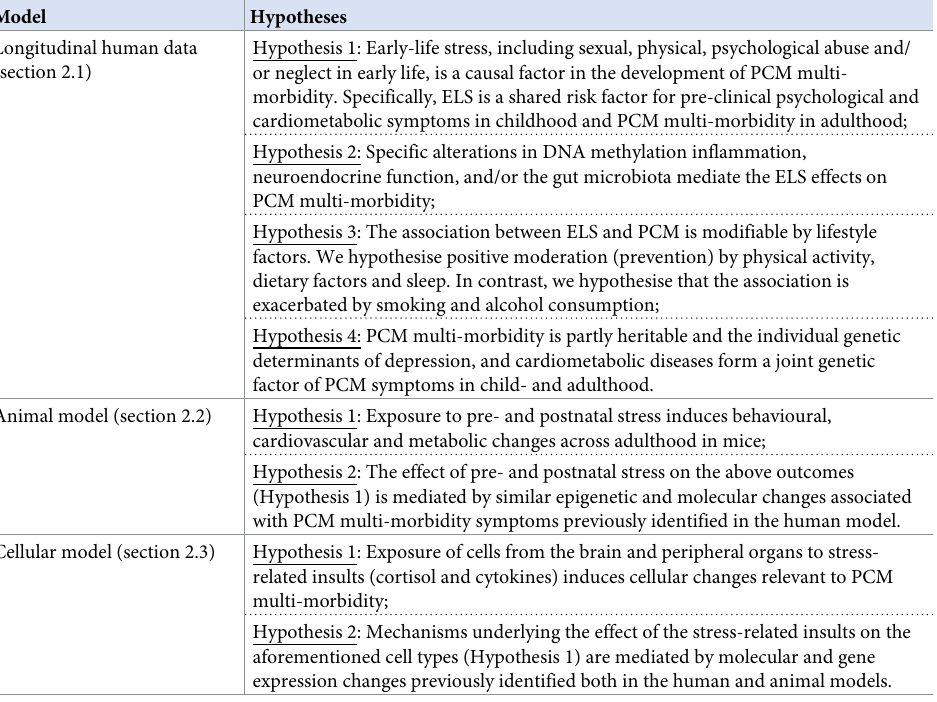
Table 2. Table of hypotheses for longitudinal human data, animal and cellular